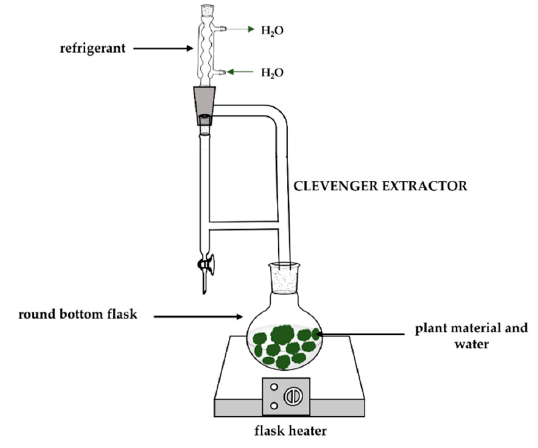
Figure 3. Schematic representation of hydrodistillation.